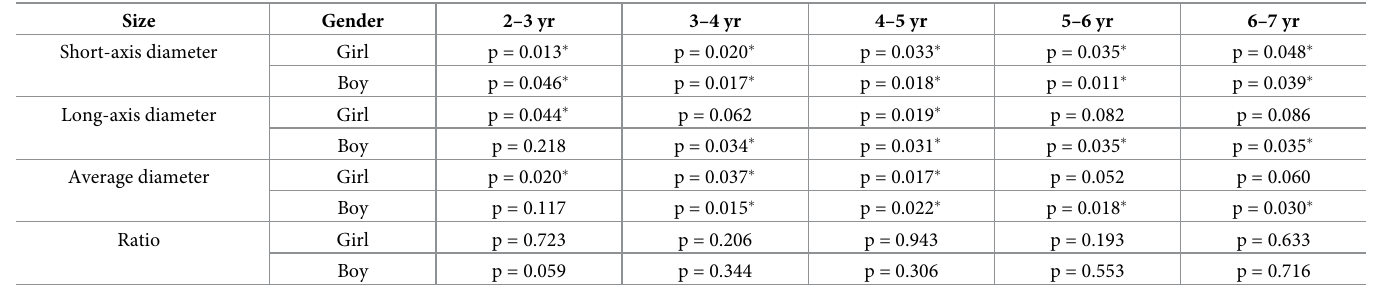
Table 2. Correlation analyses of lymphocyte count and size of the largest mesenteric lymph node. Size